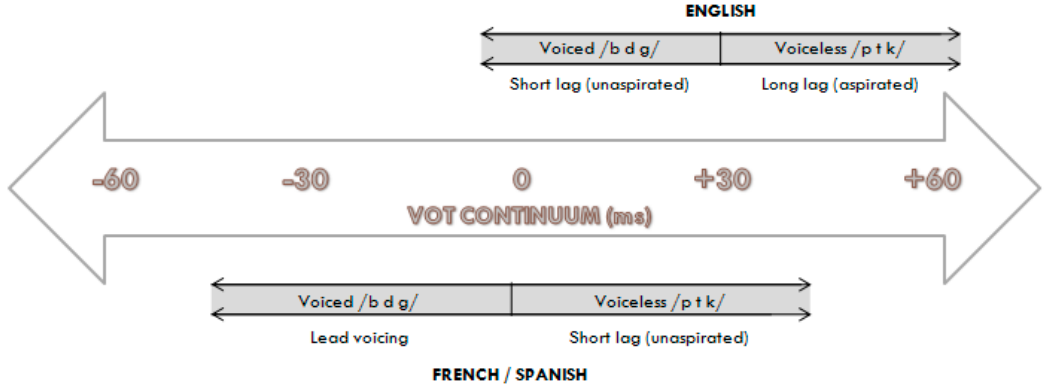
Figure 1. Schematic depiction of the relationship between English versus Spanish and French stops (adapted from Llama et al. 2010).